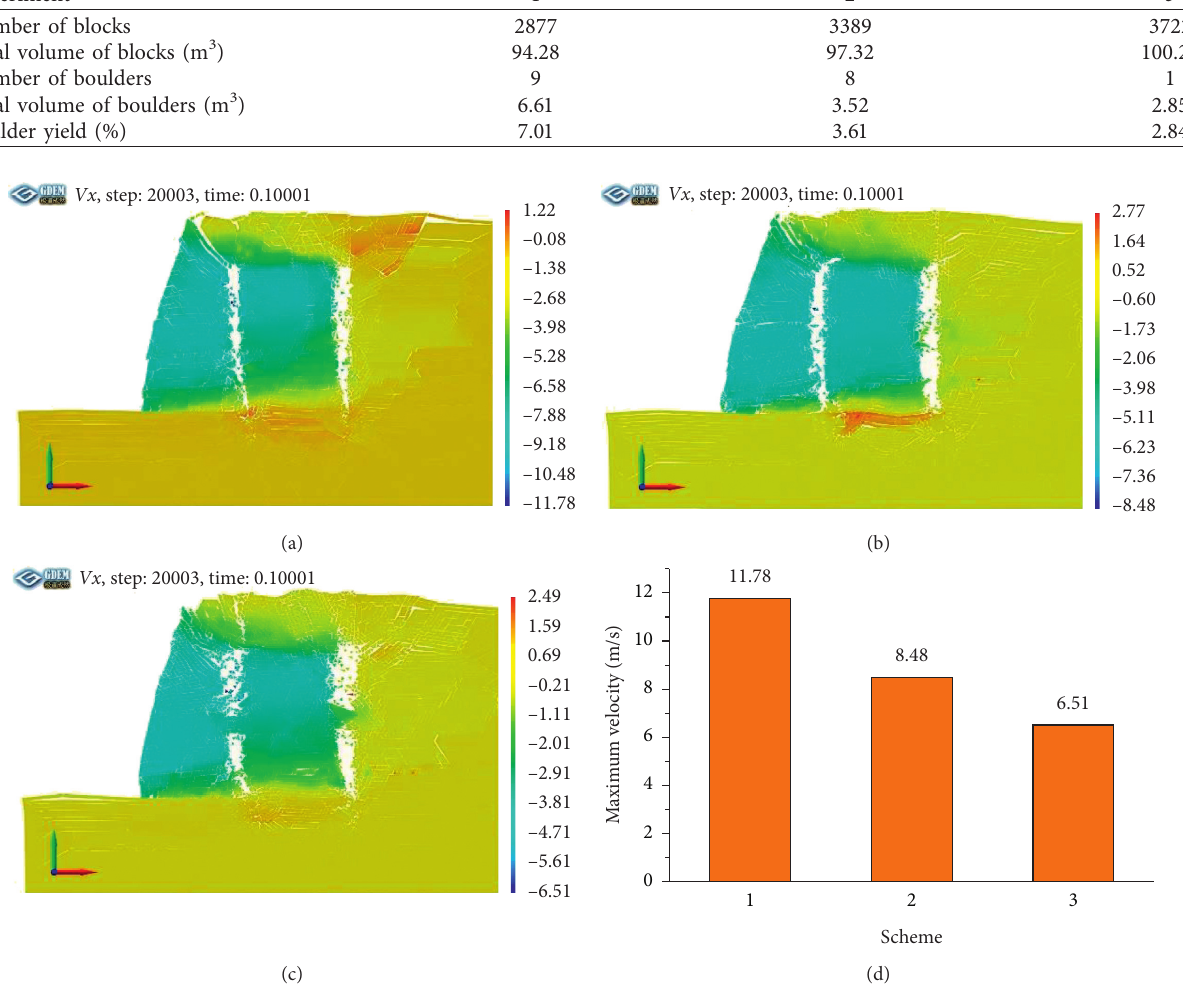
Figure 12: (a–c) The velocity distribution in the x -direction at 0.1s after blasting. (a) Scheme 1. (b) Scheme 2. (c) Scheme 3. (d) Statistics of maximum velocity- x .